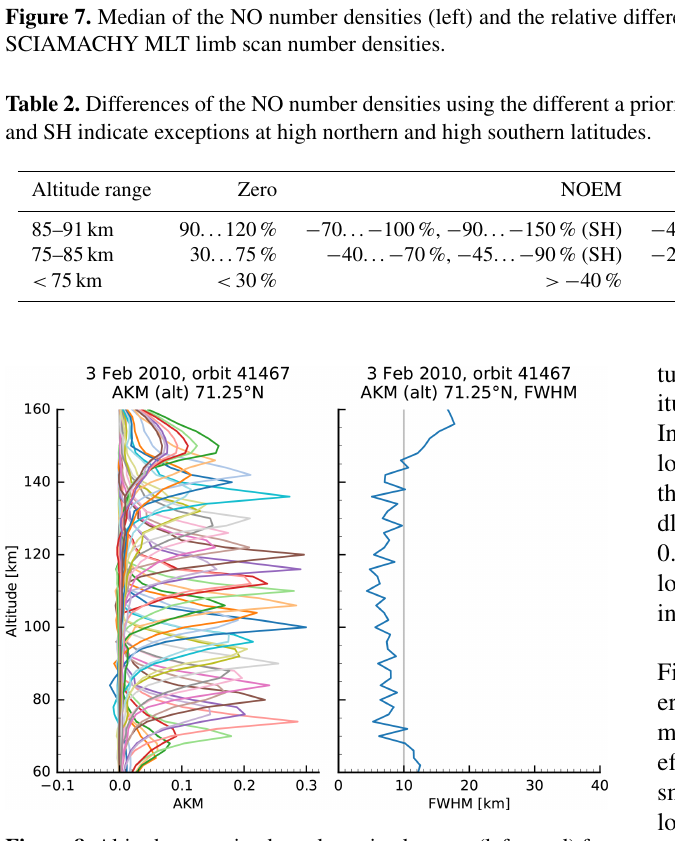
Figure 8. Altitude averaging kernel matrix elements (left panel) for a sample orbit (no. 41467, 3 February 2010) at a particular latitude grid point (71.25 ◦ N). Corresponding full width at half maximum values (right panel) are shown for the same